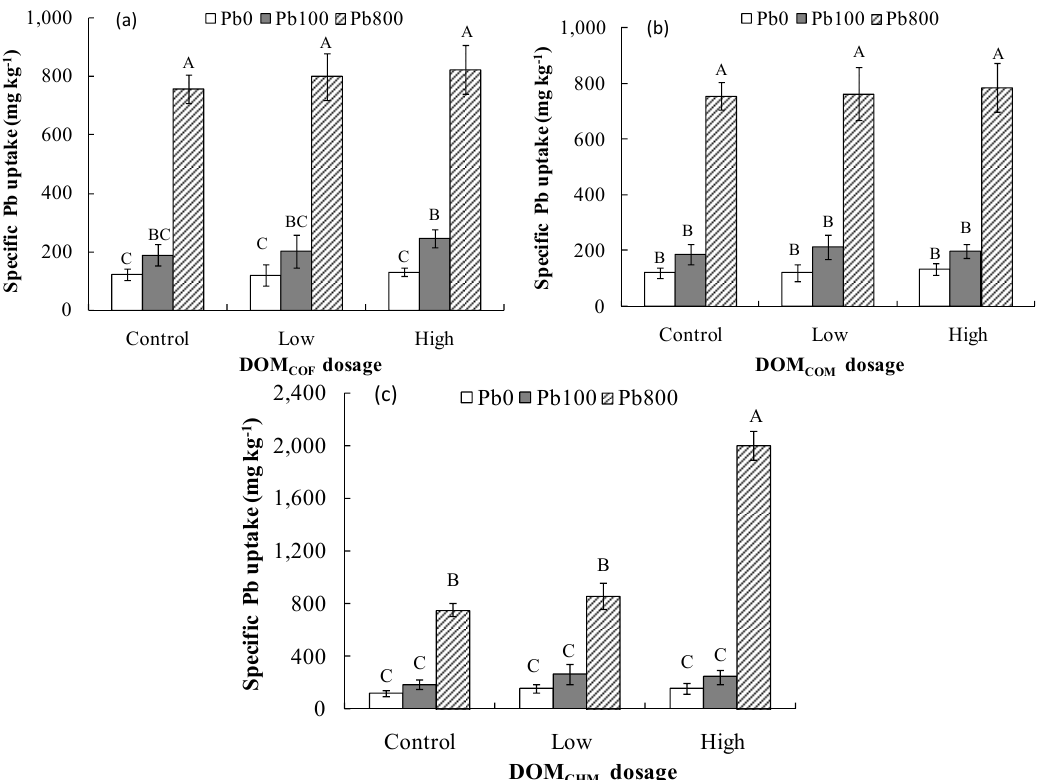
Figure 2. Specific lead uptake by root of Brassica chinensis under different addition dosage of DOM (dissolved organic matter) derived from: commercial organic fertilizer ( a ); cow manure ( b ); and chicken manure ( c ). The different capital letters above the bars indicated significant difference ( p < 0.01) among Pb levels and different DOM Level based on the Least Significant Difference test. Data are means ± SE ( n = 3).